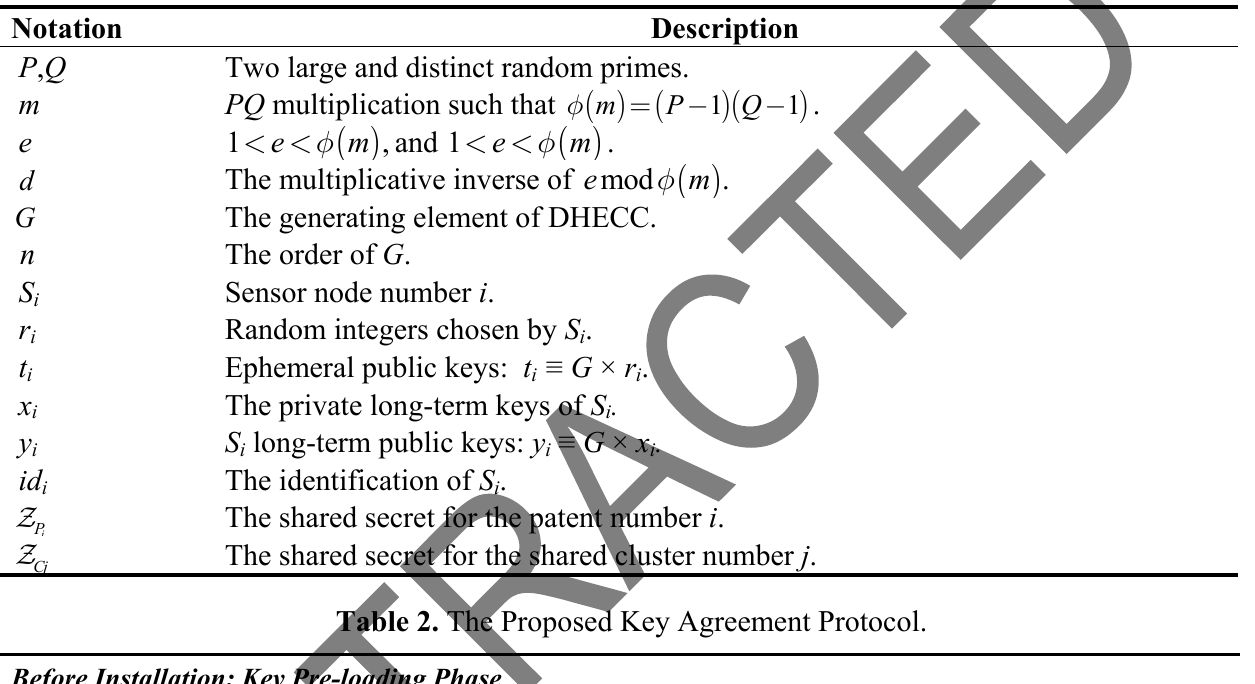
Table 1. The Proposed Protocol Notation.